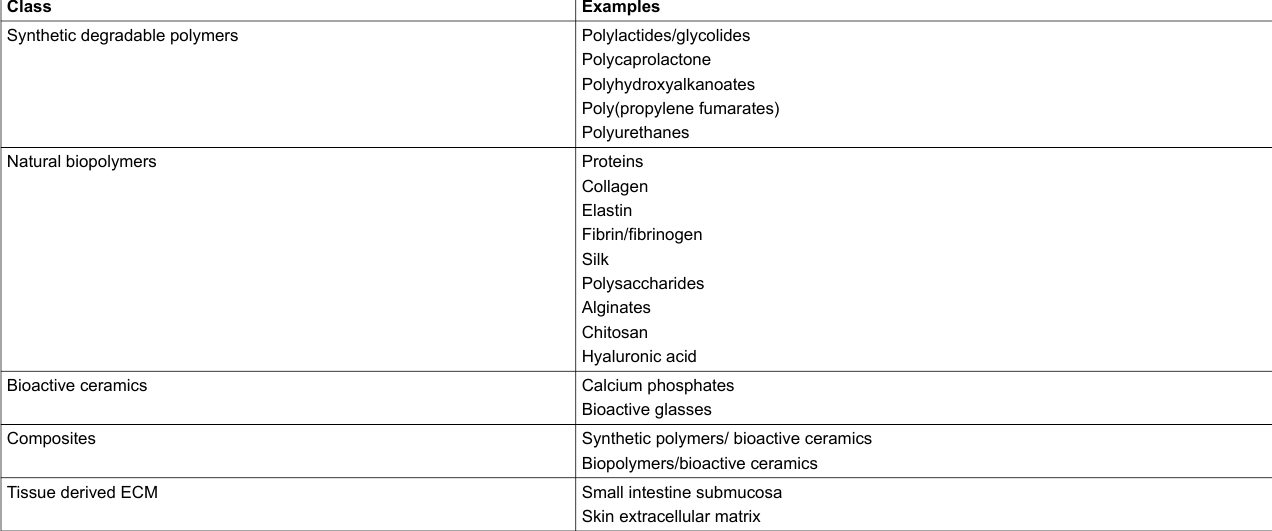
Table 1: Overview of classical biomaterials and examples used for intervertebral disc engineering.